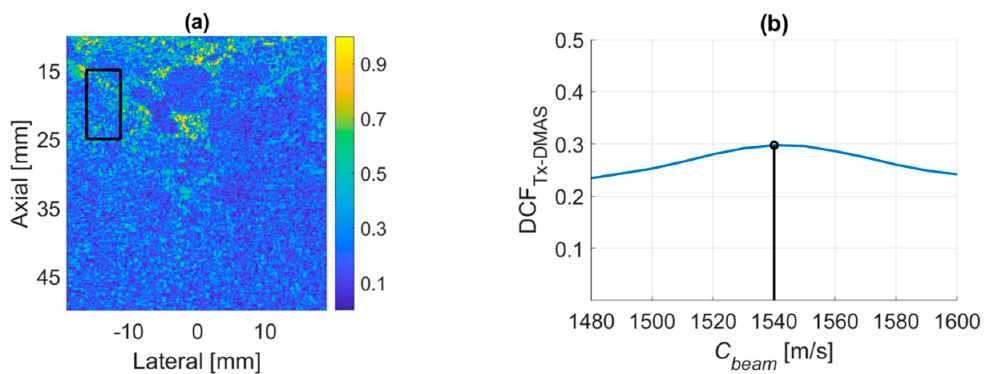
Figure 12. ( a ) DCF map of Tx-DMAS beamforming for in-vivo carotid dataset on the PICMUS platform. ( b ) Plot of averaged DCF value in ( a ) as a function of C beam .